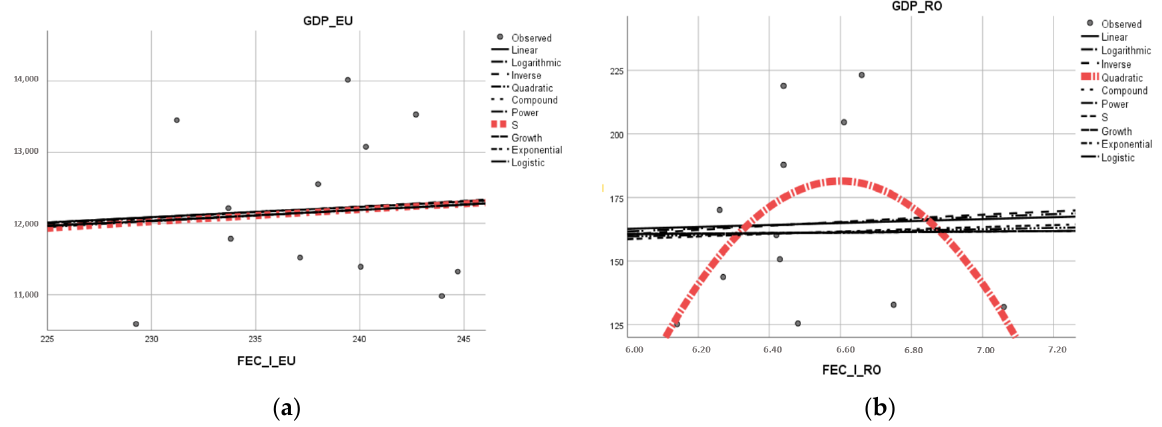
Figure 9. MLP network for identifying the influences of FEC_I on GDP: ( a ) EU; ( b ) RO. At the EU level, the regression curve analysis shows that an increase in FEC_I causes an increase in GDP. At the RO, up to a FEC_I certain value (6.6 MTOE), the increase positively influences GDP growth, after which it is negatively influenced. Thus, hypothesis H2 is partially verified.